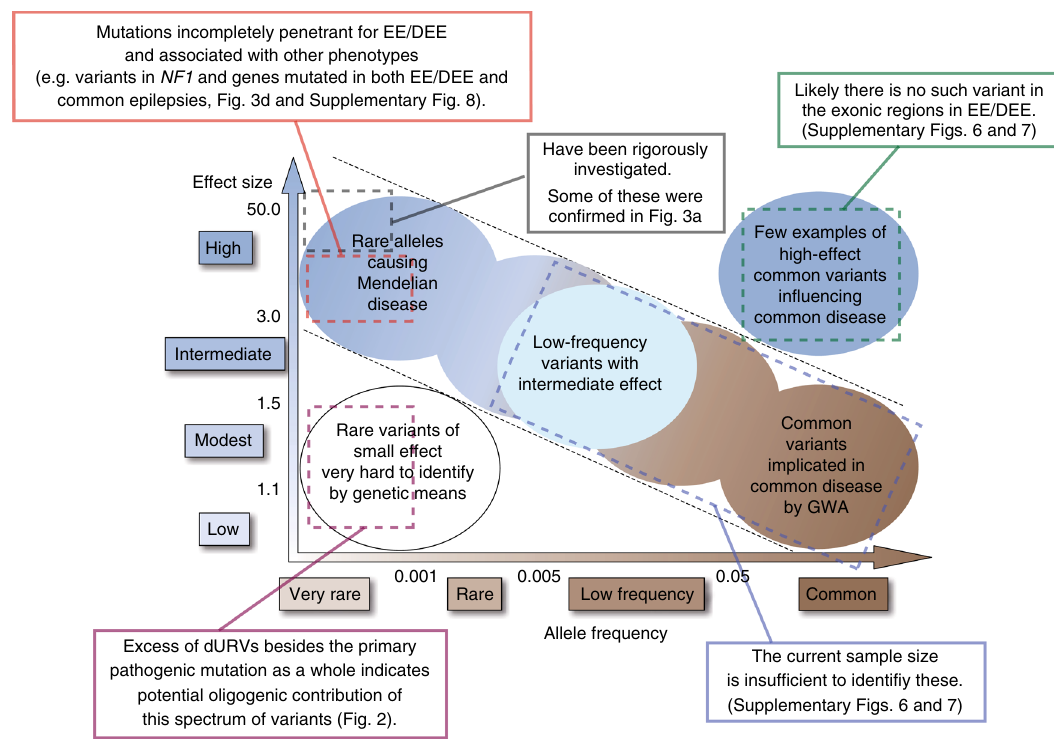
Fig. 4 Insights into the genetic architecture of EE/DEE. Summary of the insights into the genetic architecture of EE/DEE obtained from this study. Adapted from Fig. 1 of ref. 33 . Findings in this study, corresponding spectrum of allele frequency/effect size and related fi gures/tables are